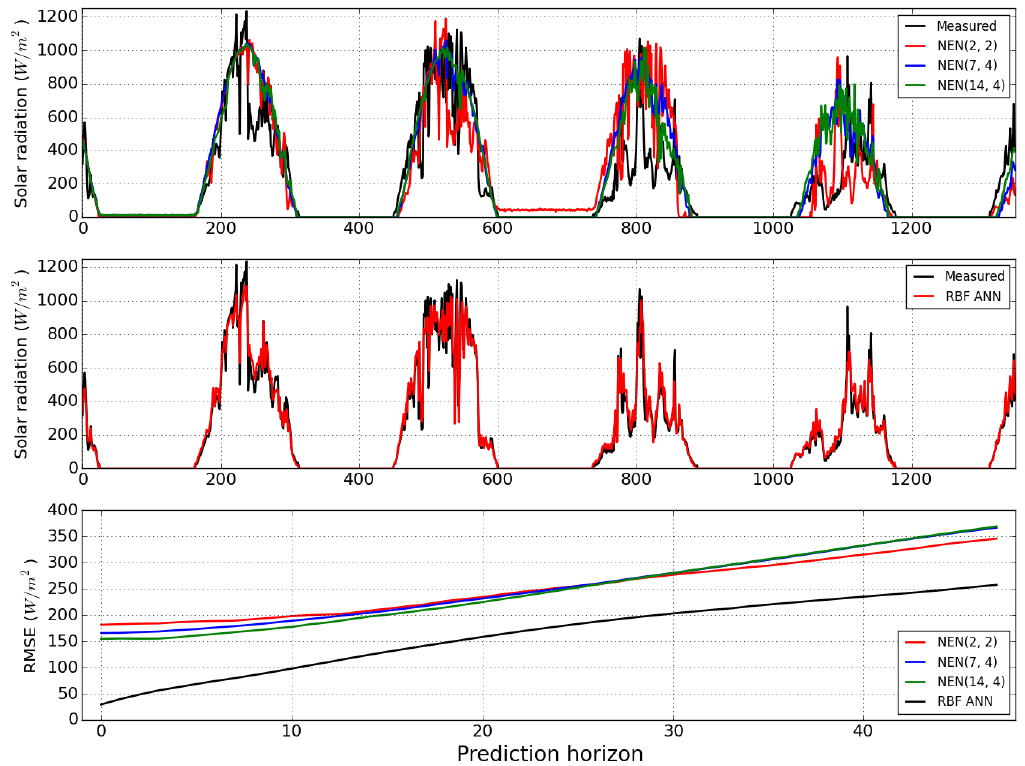
Figure 12. One-step-ahead error for the NEN algorithm ( Top ) and the RBF ANN ( Middle ), considering the last 1350 data points. Evolution of the RMSE ( Bottom ), along the prediction horizon instants, for solar radiation forecasts obtained by the RBF model (black), and the NEN algorithm: Red (2, 2), blue (7, 4) and green (14, 4). Table 3. RMSEs of Solar Radiation.